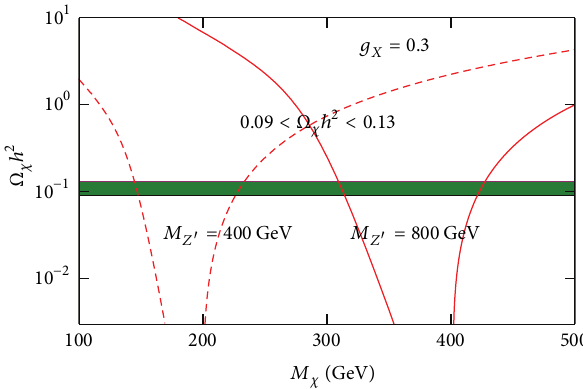
Figure 3: Relic density of stable fourth-generation neutrino 𝜒 as a function of its mass for 𝑀 𝑍 󸀠 = 400 GeV (dashed) and 800 GeV (solid) with a coupling constant 𝑔 𝑋 = 0.3 . The green band represents the observed DM density. Plot from